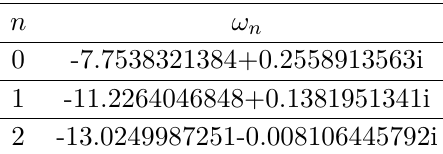
Table 1 . Quasinormal modes of scalar field in the planar RNAdS black hole for Q = 2 and q = 6 . 5 . There are two unstable modes in the spectrum.